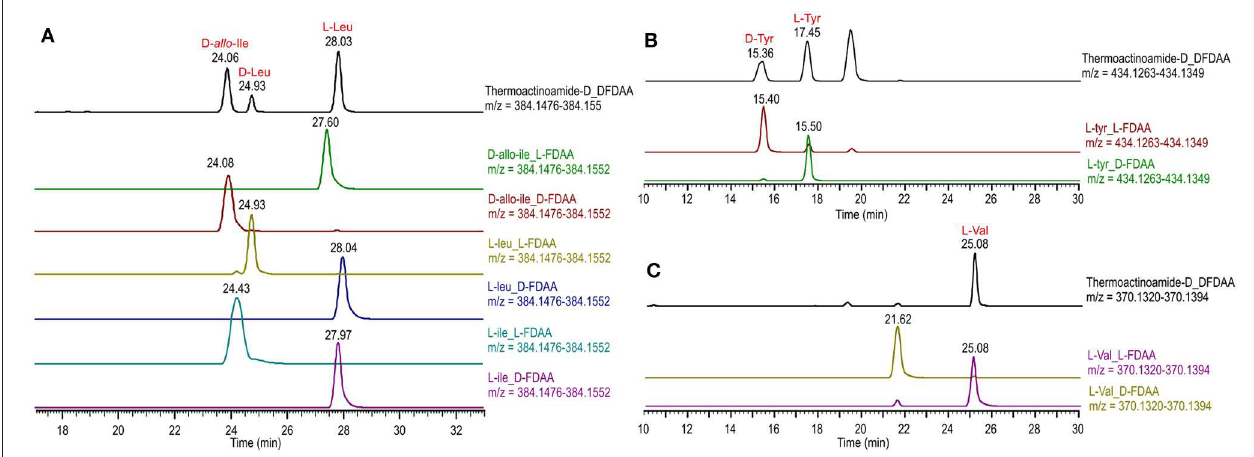
FIGURE 4 | Advanced Marfey’s analysis of compound 4 using a pentafluorophenyl (PFP) bonded-phase column. (A) Extracted-ion chromatograms at m/z 384.1514 of the D -FDAA derivatives from the hydrolysis of 4 and of D - and L -FDAA derivatives L -Leu, L -Ile, and D - allo -Ile. (B) Extracted-ion chromatograms at m/z 434.1306 of the D -FDAA derivatives from the hydrolysis of 4 and of D - and L -FDAA derivatives L -Tyr. (C) Extracted-ion chromatograms at m/z 370.1357 of the D -FDAA derivatives from the hydrolysis of 4 and of D - and L -FDAA derivatives L -Val.